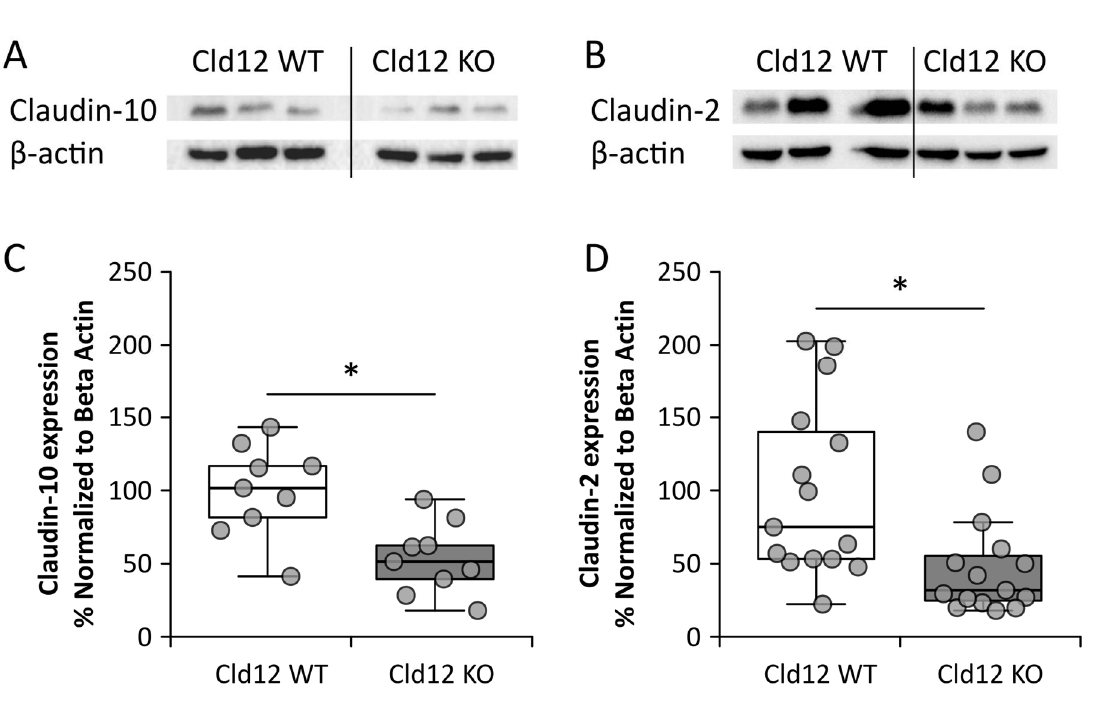
Figure 6. Claudin-12 wild type (WT) and knockout (KO) mouse renal cortical protein expression. ( A , C ) Claudin-10 and ( B , D ) Claudin-2. * p < 0.05.